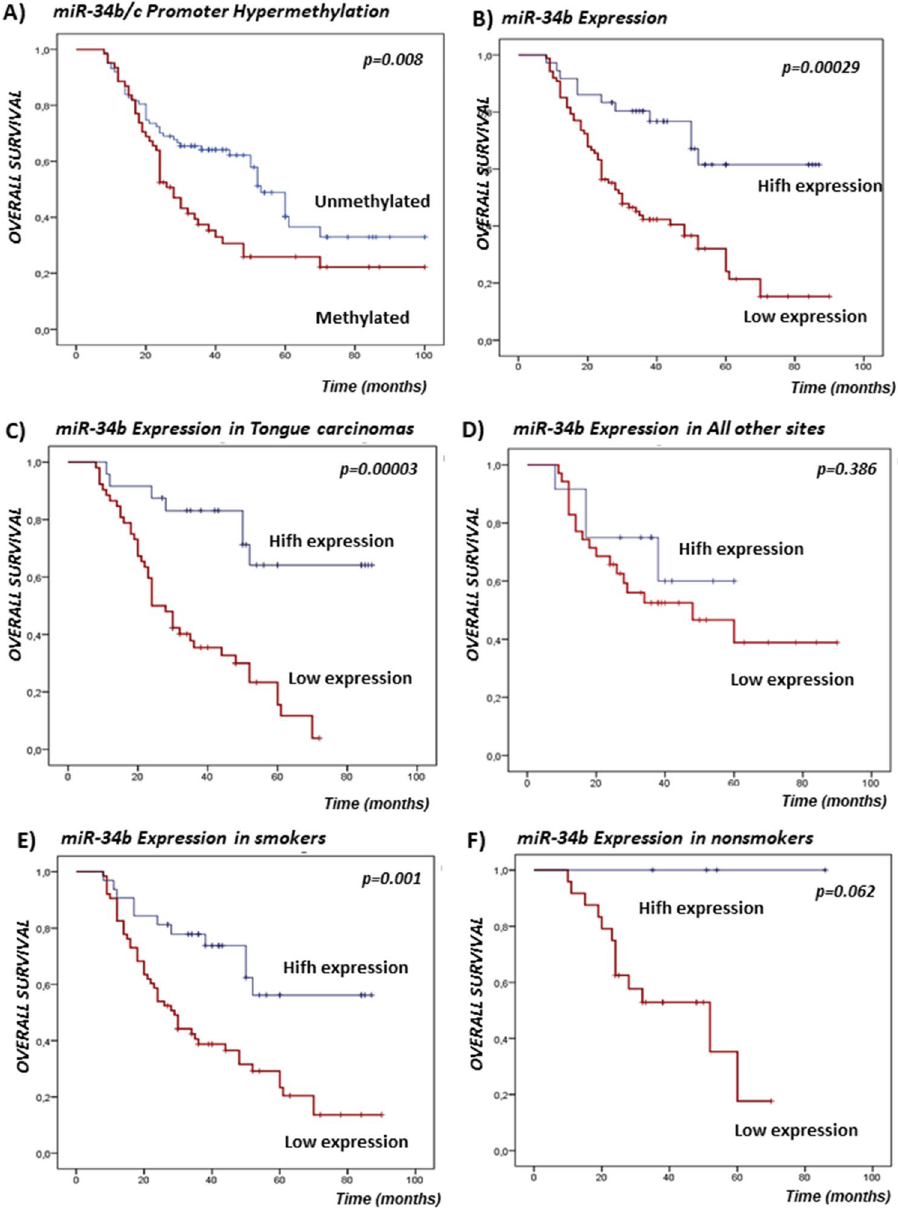
Figure 1. Kaplan–Meier curves with log-rank test for overall survival (OS) of the OSCC patients cohort. ( A ) Survival according to the miR-34b/c promoter hypermethylation status. ( B ) Survival according to the miR-34b gene expression. ( C ) Survival according to the miR-34b expression in tongue carcinomas patients. ( D ) Survival according to the miR-34b expression in patients with OSCC of all other sites. ( E ) Survival according to the miR- 34b expression in smokers. ( F ) Survival according to the miR-34b expression in